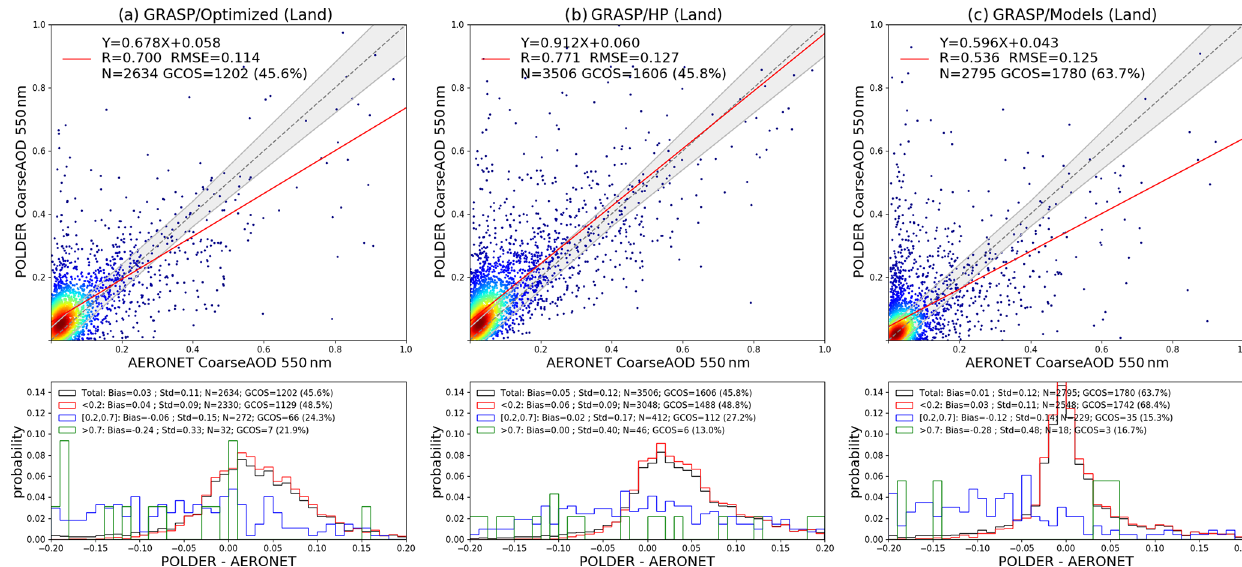
Figure 15. Validation of PARASOL/GRASP ( a GRASP/Optimized, b GRASP/HP and c GRASP/Models) coarse-mode AOD at 550nm over land in 2008. The gray envelope indicates GCOS requirement applied for AODC: max (0.04 or 0.1AODC). The probability density functions of differences (POLDER–AERONET) are present in the lower panel. The black, red, blue and green solid lines indicate all AODC conditions: any AODC, AODC < 0.2, 0.2 ≤ AODC ≤ 0.7 and AODC > 0.7, respectively.